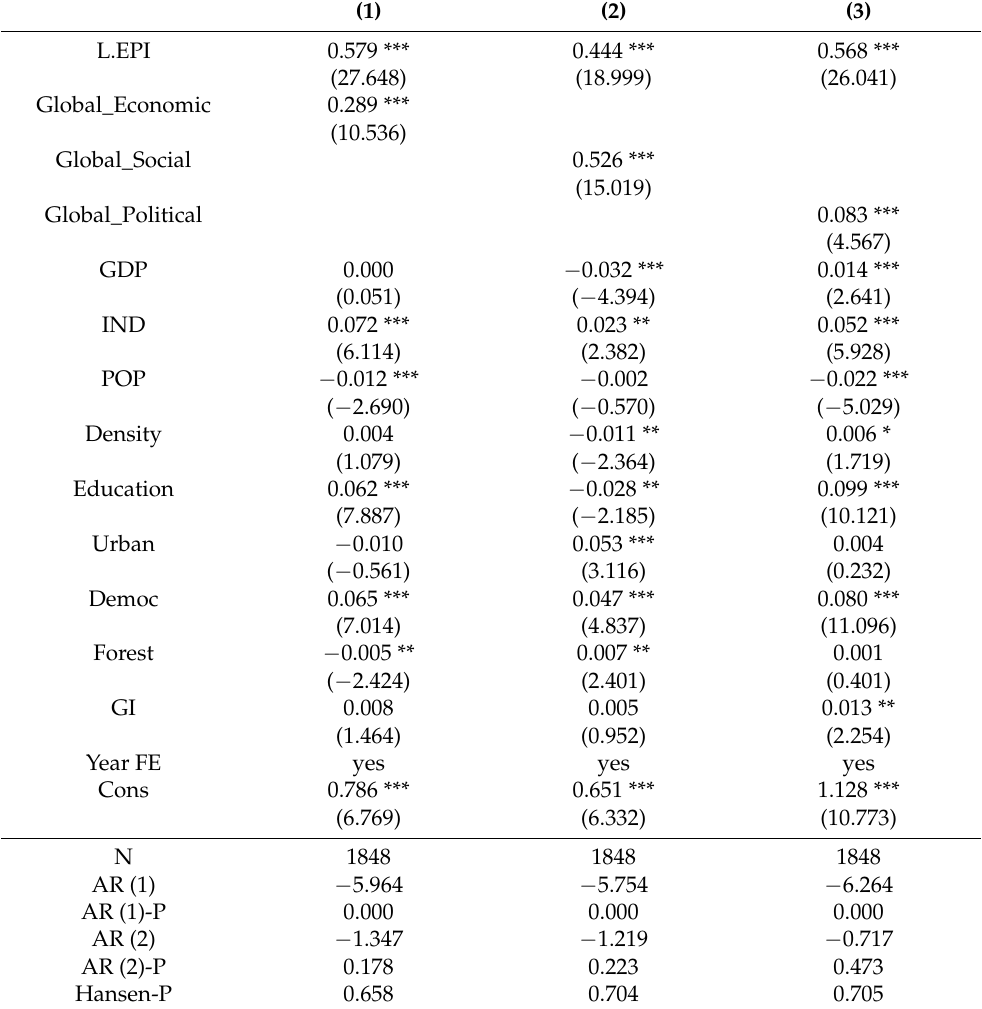
Table 5. Robustness test—specific dimension of globalization.